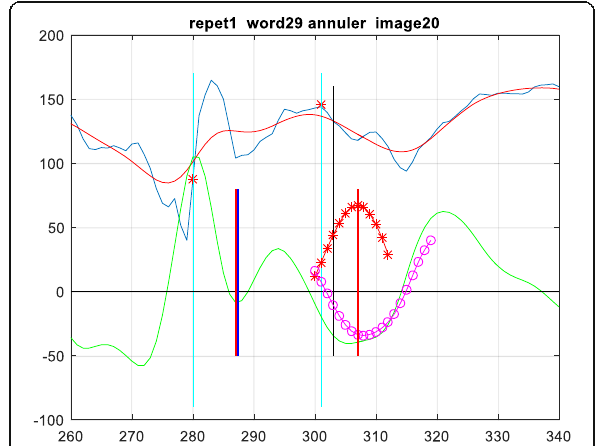
Fig. 9 The figure is plotted along the middle point of the upper inner lips . Blue curve : original luminance variation. Red curve : the smoothed luminance. Green curve : the smoothed first derivative. Red curve with stars: correlation values between the template and the first derivation curve in function of the position of the template. Magenta curve with stars: the proposed hybrid dynamic template. Vertical black line around the 301 position corresponds to the initial searching position. The bold red line around position 307 located in the maximum correlation value corresponds to the estimated lower outer lips position